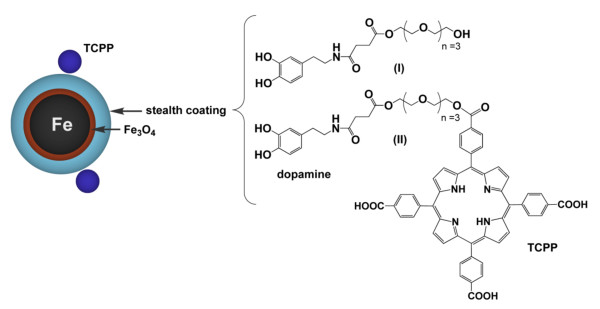
Composition of the 4-tetracarboxyphenyl porphyrin (TCPP)-labeled, dopamine-anchored tetraethylene glycol ligands. Nanoparticles of 7.2 nm (outer diameter) require approximately 120 dopamine-anchored ligands (assuming a monolayer).